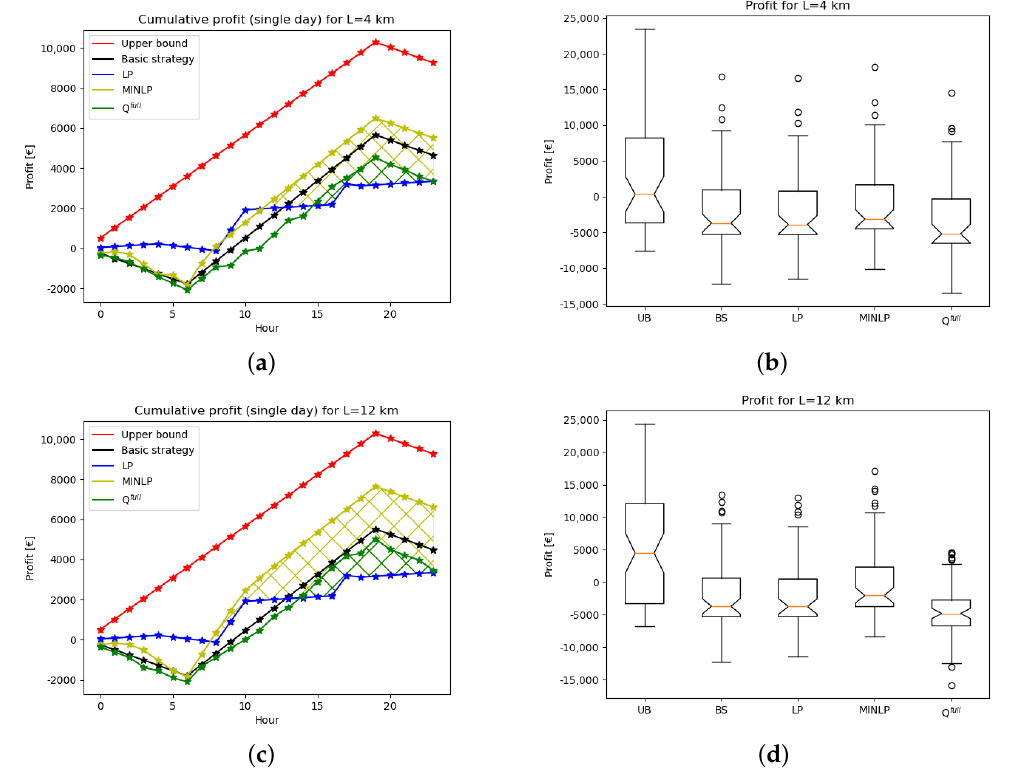
Figure 4. ( a ) The single-day cumulative profit for L “ 4 km. ( b ) The box-plot profit for L “ 4 km. ( c ) The single-day cumulative profit for L “ 12 km. ( d ) The box-plot profit for L “ 12